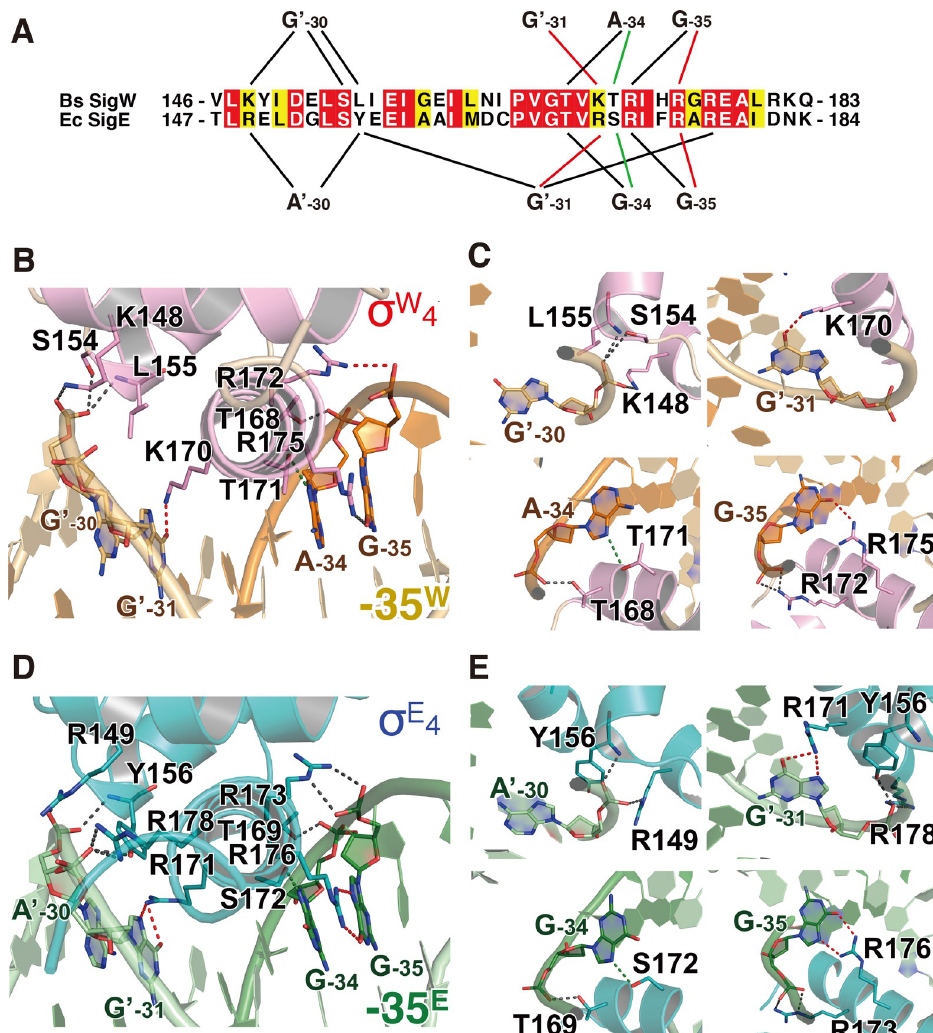
Fig 2. Interactions between σ 4 domain and -35 promoter element. (A) Schematic diagram representing the hydrogen bonds between σ 4 and the -35 element. The sequences of the -35 element-binding interface in B . subtilis SigW and E . coli SigE are aligned. Black lines indicate the backbone interactions, green lines show the purine-specific interactions, and red the guanine-specific interactions. (B, C) Hydrogen bonds between σ W 4 and -35 W . Residues and nucleotides, which form hydrogen bonds, are drawn as pink and orange stick models, respectively. Dotted lines indicate hydrogen bonds between σ W 4 and -35 W . (D, E) Interactions between σ E 4 and -35 E (PDB ID: 2H27) [8]. Residues and nucleotides, which form hydrogen bonds, are drawn as teal and dark green stick models. The ribbon models are drawn at the same orientations as those in (B) and (C). Dotted lines indicate hydrogen bonds between σ E 4 and -35 E . The dotted lines in (B-E) are colored by the same scheme as the lines in